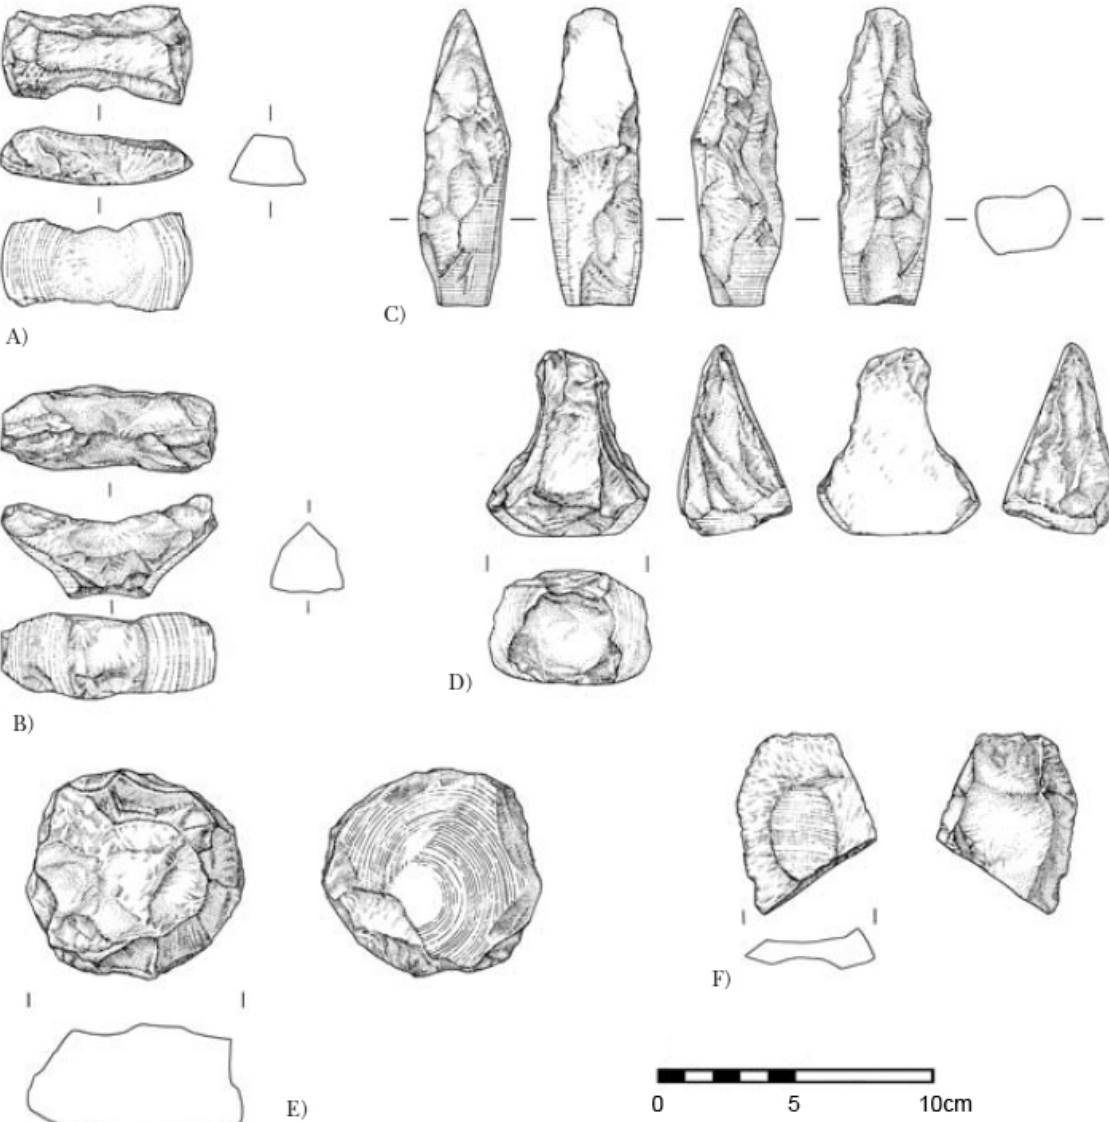
Figure 11. A drill-bit assemblage collected from the site of Al-Shaykh Sa c id-Wadi Zabayda in Middle Egypt, dating to the New Kingdom (1550-1069 BCE) and Third Intermediate Period (1069-653 BCE), (source: Willems et al. 2009: fig. 3; drawings by A. van den Broeck).